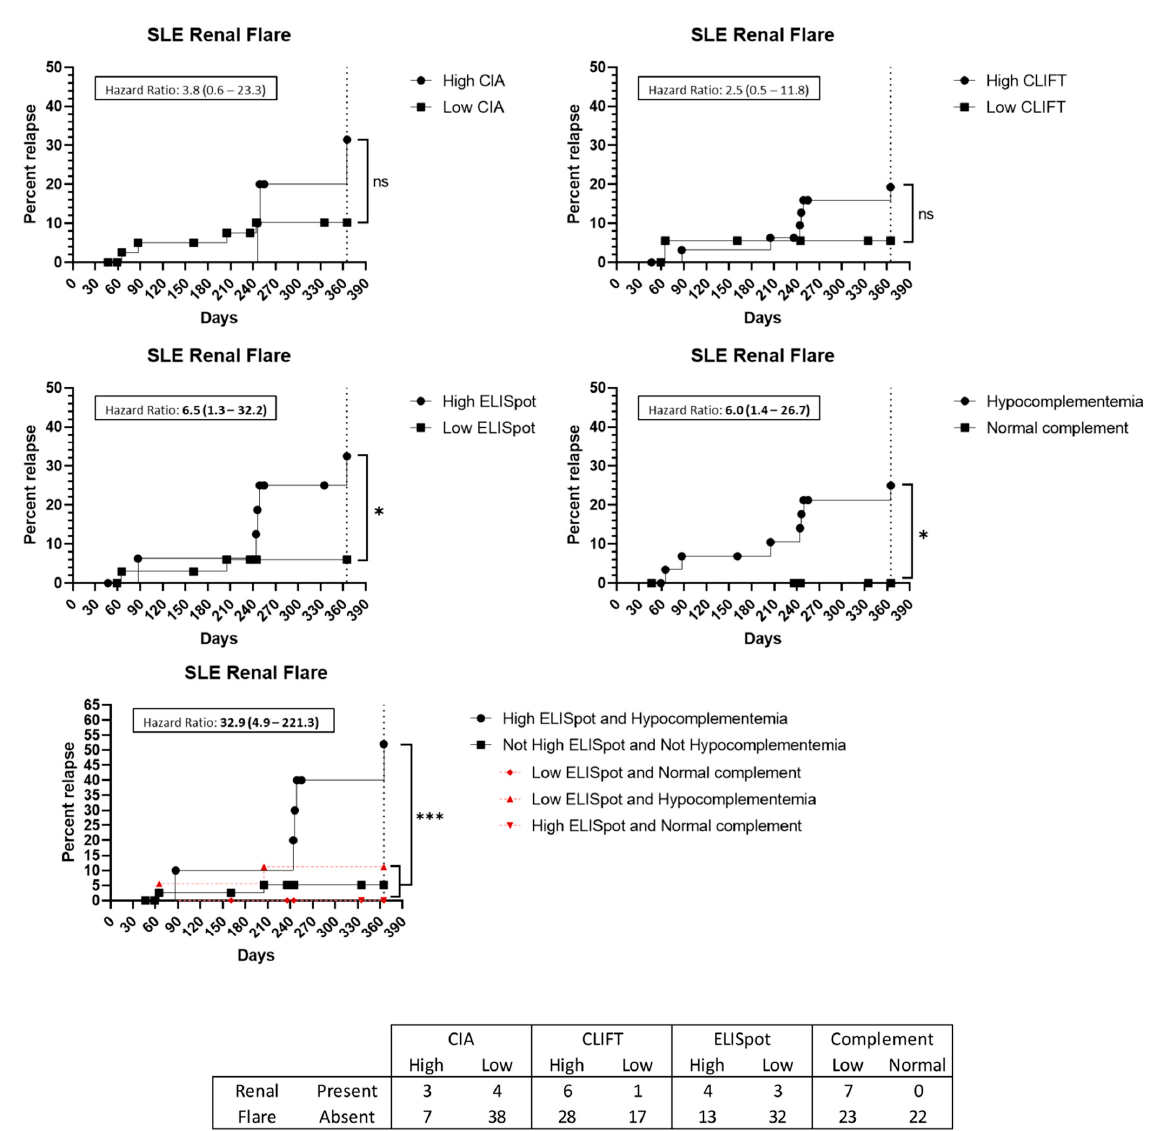
Figure 5. Renal flare up prediction capacity: Kaplan–Meier survival analysis and hazard ratio. X-axis: days from sampling to flare up. Y-axis: percentage of patients presenting with a flare up. ns: non-significant. *: p < 0.05. ***: p < 0.001. Abbreviations: CIA: chemiluminescence immunoassay;